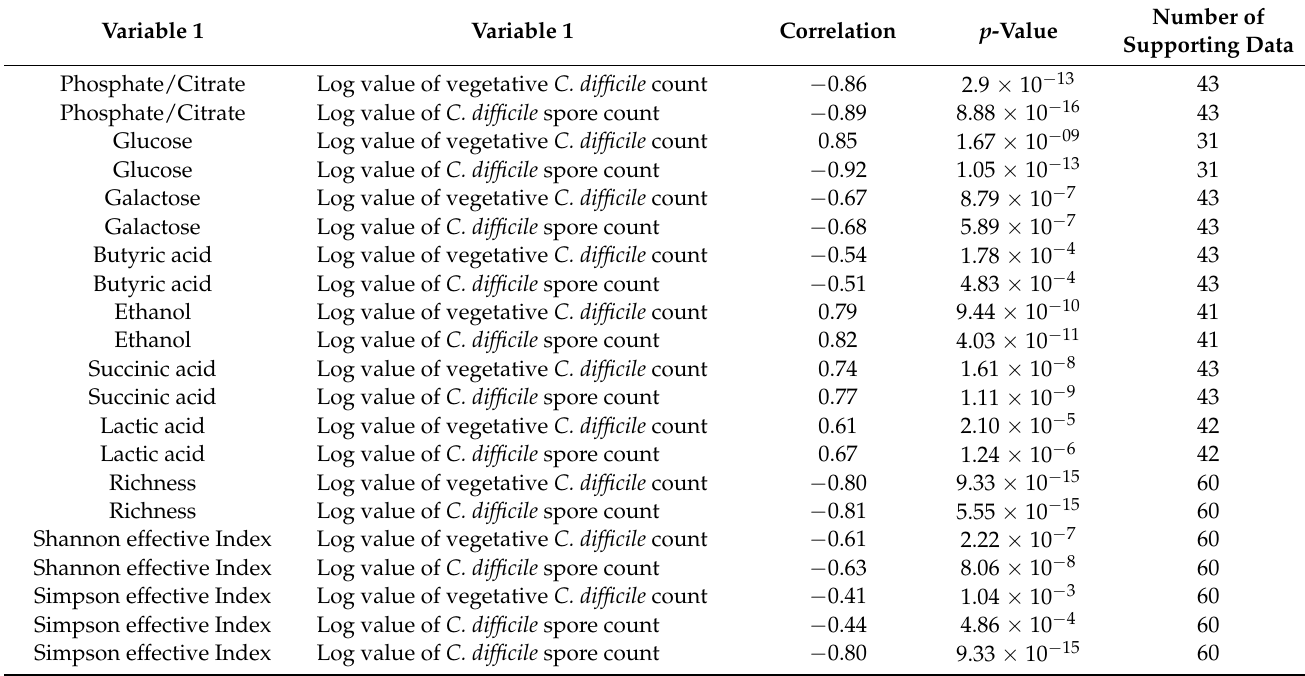
Table A2. Individual pairwise correlation coefficients and p